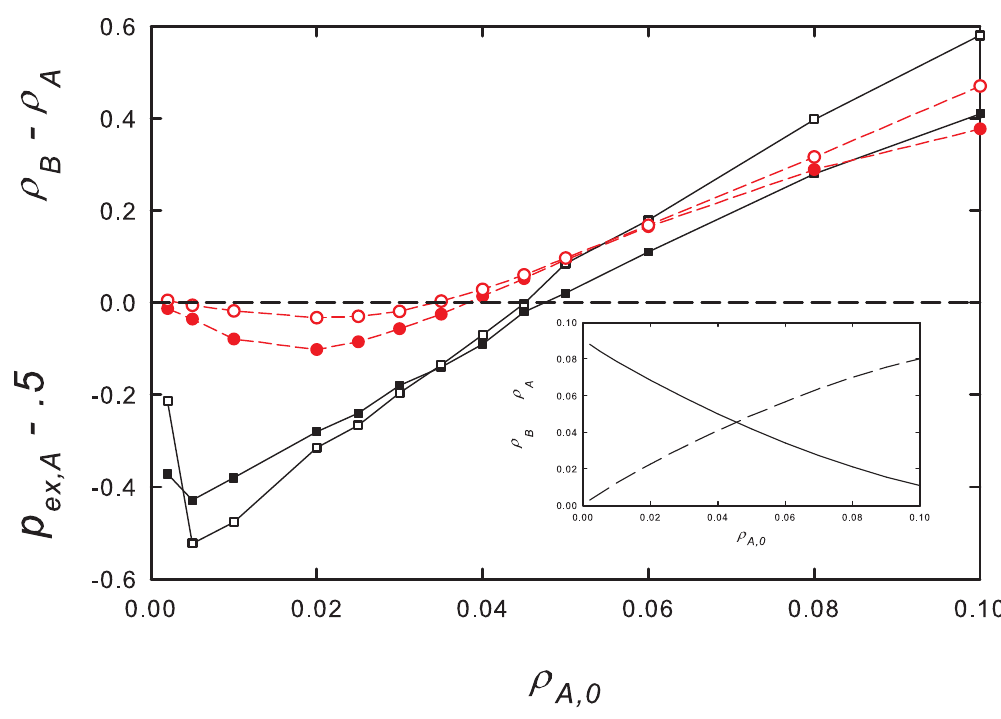
Fig 3. (Color online) MF equations with additive noise. Species- A extinctionprobability p ex , A − .5 (filled symbols) and excess mean populationdensity ρ B − ρ A (open symbols) versus initial density ρ A = ρ B for λ = 1.1 and α = 0.1. Noise intensity γ = 0.01 (squares and solid lines) and 0.1 (circles and dashed lines). Points reflect averages over 10 3 —10 4 independentrealizations.Density differencesare multipliedby a factor of 10 for visibility. Error bars smaller than symbols. Inset: stationary population densities (cid:22) r noise.